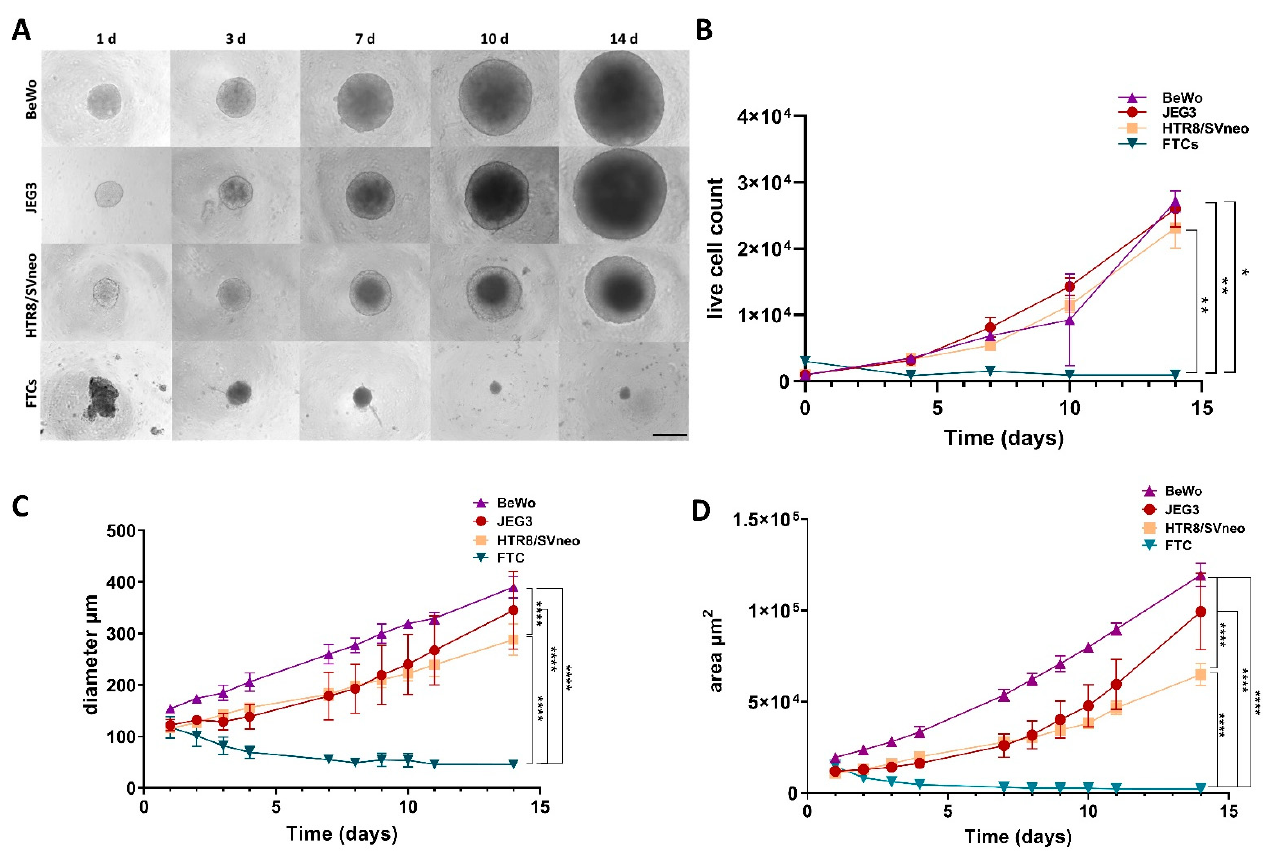
Figure 1. Trophoblast spheroid growth curve. Bright-field images of BeWo, JEG3, HTR8/SVneo and FTC spheroids at day 1, 3, 7, 10 and 14 ( A ), number of live cells per spheroid at day 4, 7, 10 and 14 ( B ) and growth curves for the representative trophoblast spheroids over a period of two weeks as a function of total spheroid area in µm 2 ( C ) or spheroid diameter in µm ( D ). Scale bar 100 µm. * p <0.05; ** p < 0.01; **** p < 0.0001.